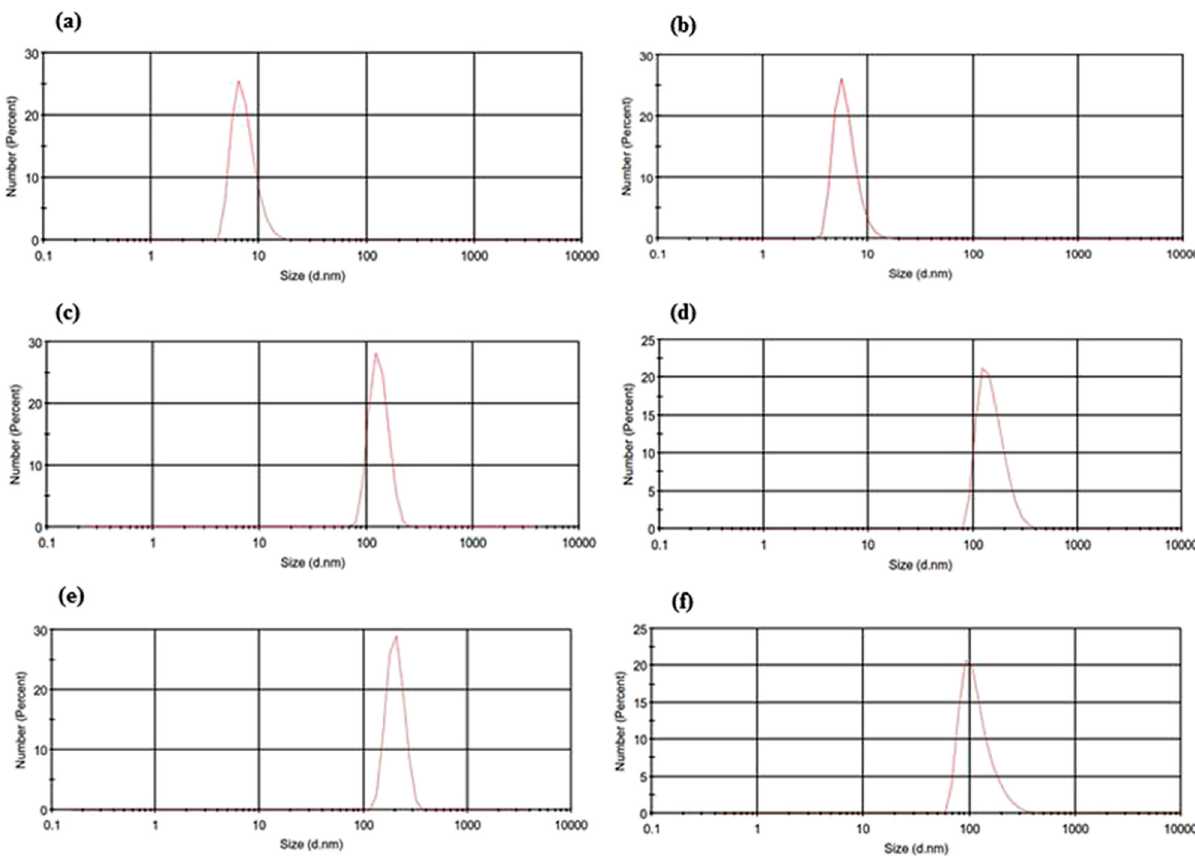
Figure 2: Nanodroplet size distributions of the prepared thyme nanoemulsions using Tween 80 ( a ) , Tween 20 ( b ) , saponin ( c ) , sodium caseinate ( d ) , Arabic gum ( e ) , and xanthan gum ( f )